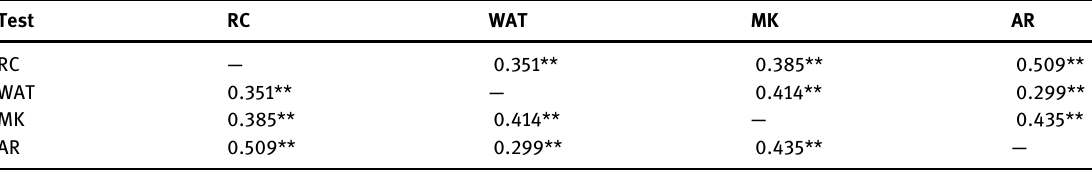
Table 1: Correlations among the Scores of word associates test, morphological knowledge, analytic relations, and reading comprehension ( N = 155